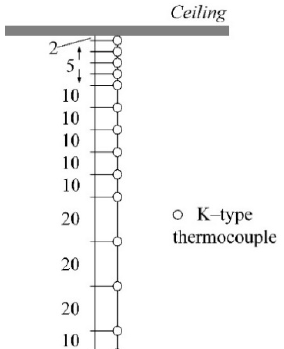
Figure 6. Vertical temperature measuring positions of a thermocouple pile (dimensions in cm).